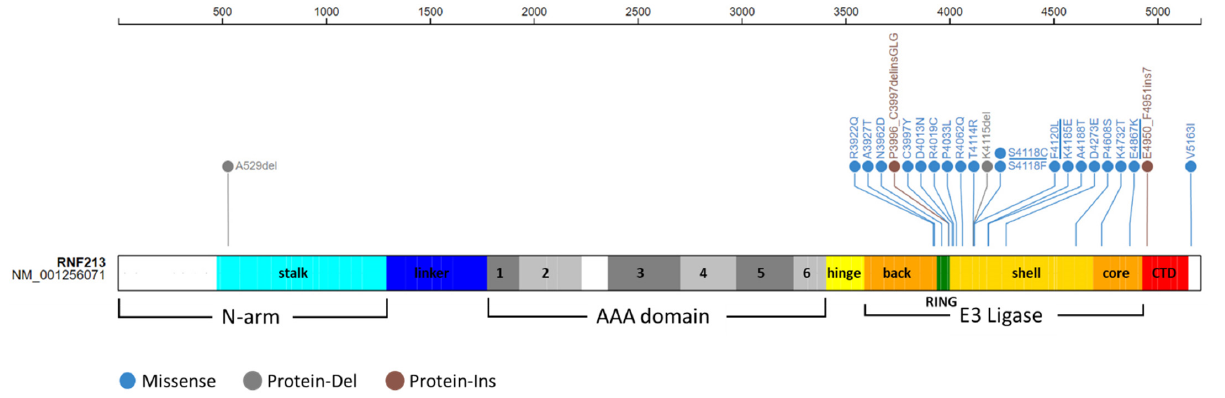
Figure 6. Graphical view of RNF213 protein showing its functional domains and published pathogenic variants reported in European populations . Functional motifs of RNF213 (5207 amino acids) are differently colored. Pathogenic variants associated with moyamoya angiopathy are color grouped according to their functional effect. The variants identified in the present study are underlined.